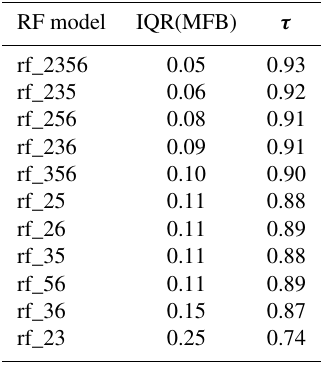
Table 1. Evaluation metrics of the random forest models developed to derive [CCN0.4] from other